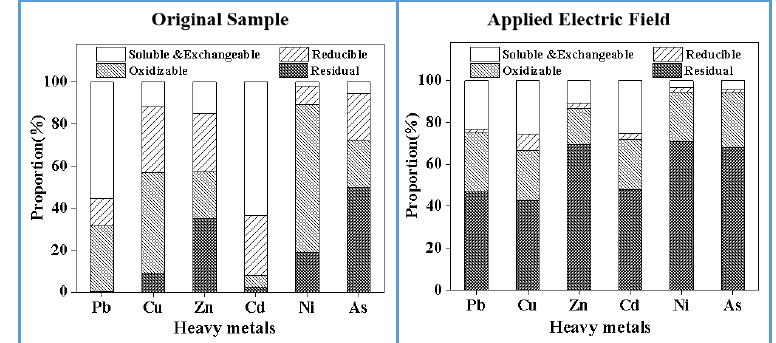
Figure 10. Heavy metal forms of treated MSWI fly ash.